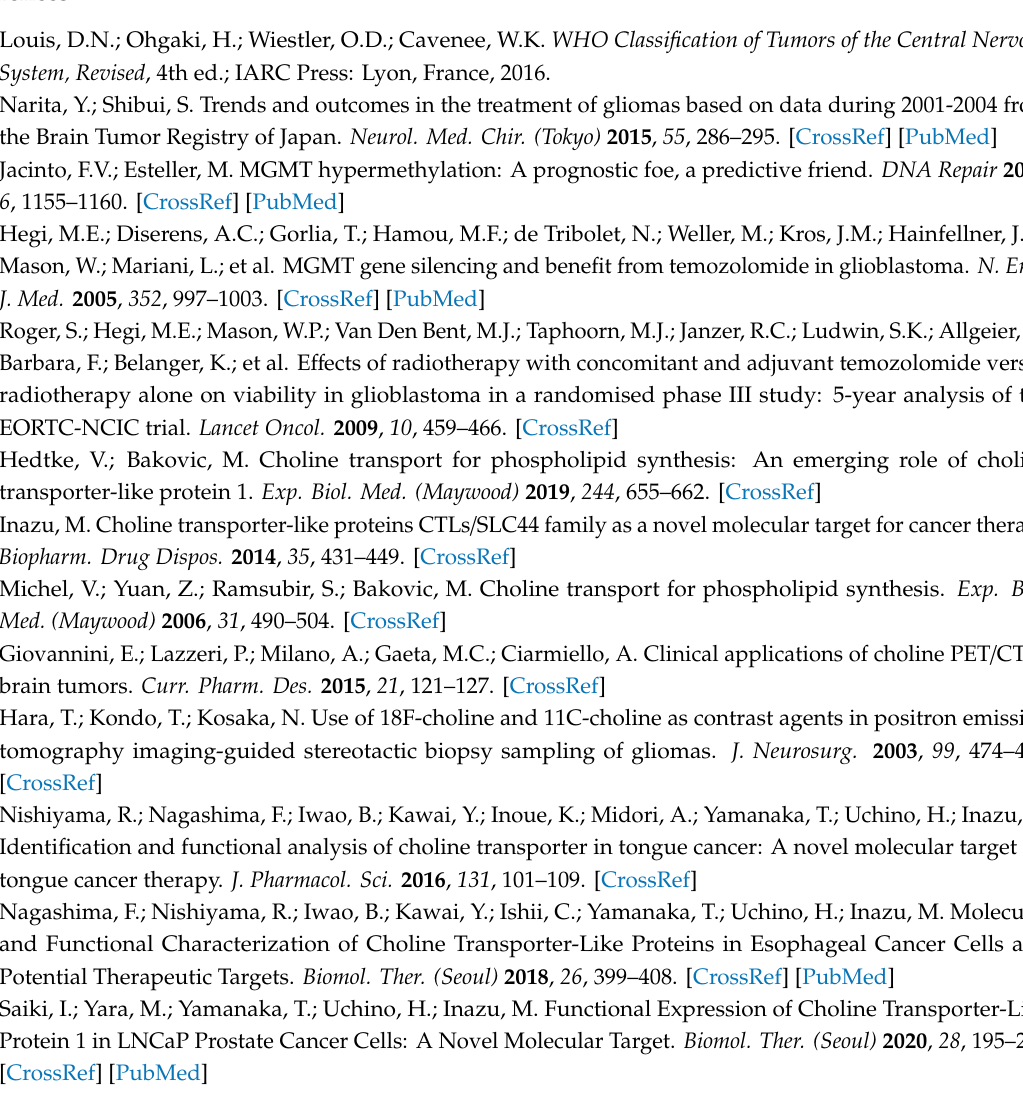
Figure S1: E ff ect of Amb4269951 on cell viability in various cancer cell lines. Cells were pre-incubated with various concentrations of Amb4269951 for 24 h, and then the cells were counted. The results are given as a percentage of the findings in the vehicle control. Each point represents the mean ± SD ( n =